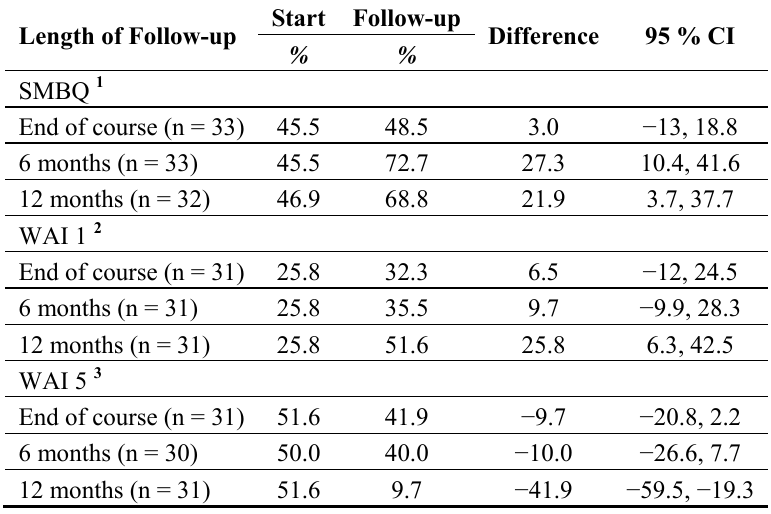
Table 4. Differences in paired proportions, with 95% confidence interval (CI) for participants scoring ≤ 3.75 on the SMBQ, 9 or 10 on WAI 1, and reporting more than 14 days of sick leave on WAI 5, respectively. Comparing start of course with follow-up at course end, and 6 and 12 months, respectively.